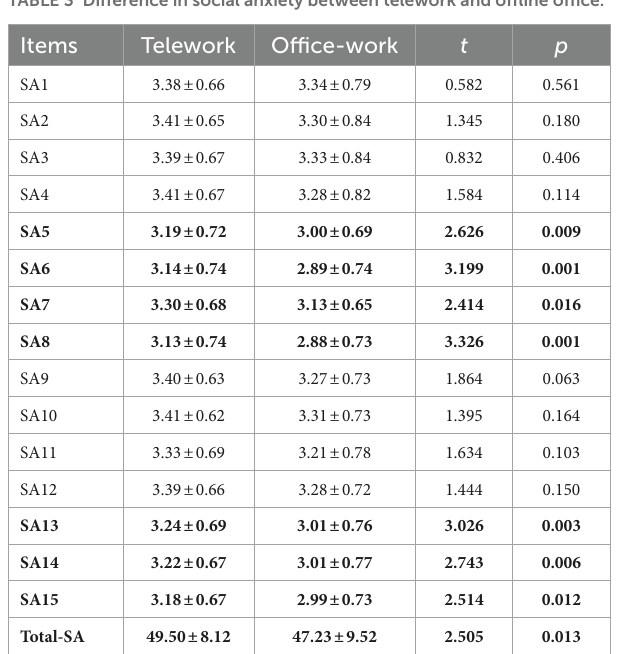
TABLE 3 Difference in social anxiety between telework and offline office.